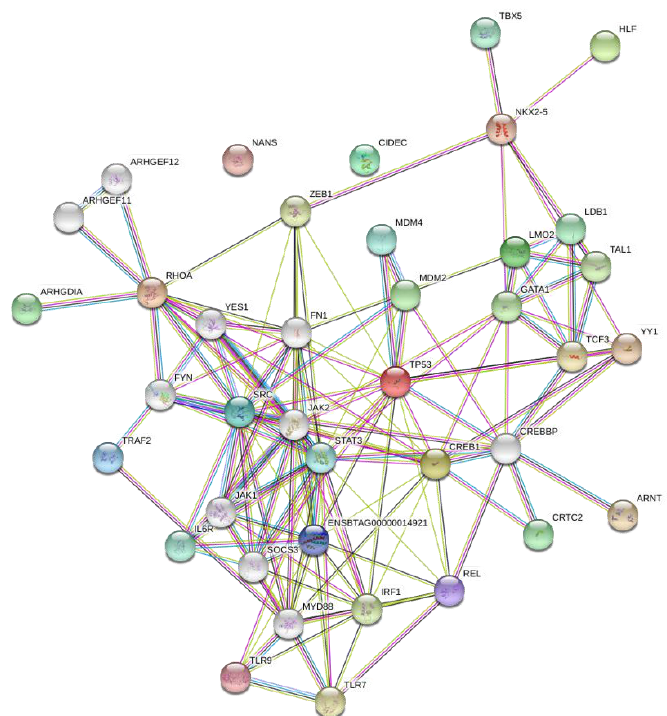
Figure 4. Network analysis of predicted genes. Protein-protein interaction network of immune genes associated with BCoV. (Edge color legend; blue: from curated database, pink: experimentally determined, green: text mining, brown: co-expression).